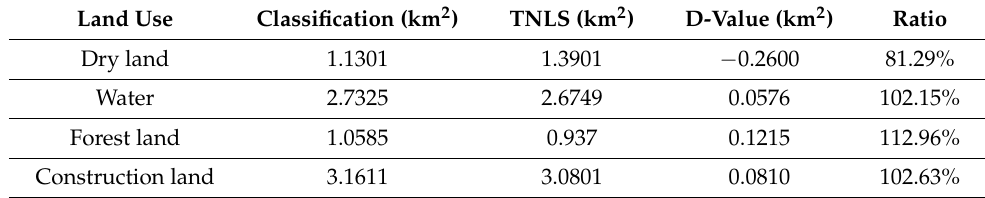
Table 5. Comparison between classification results and TNLS